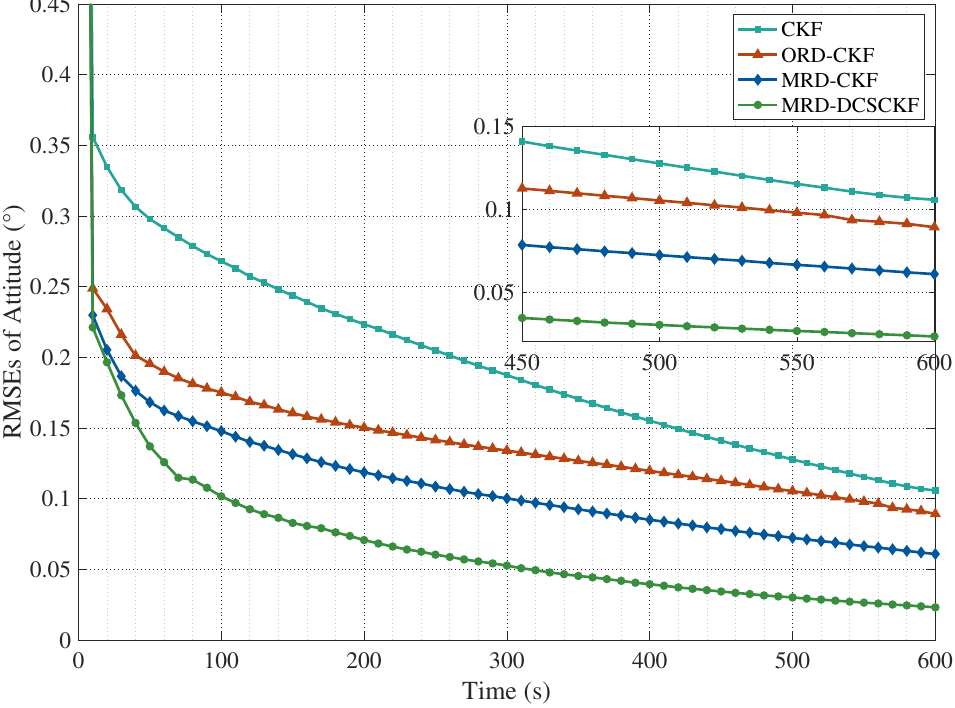
Figure 10. RMSEs of the attitude with CKF, ORD-CKF, MRD-CKF, and MRD-DCSCKF.